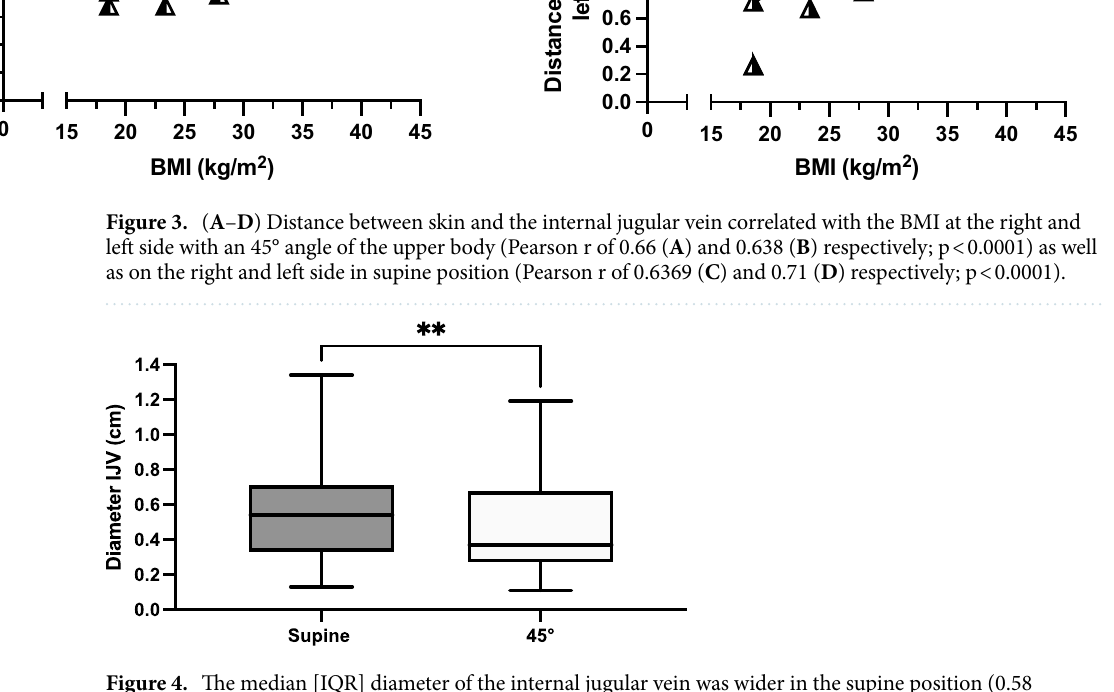
Figure 4. The median [IQR] diameter of the internal jugular vein was wider in the supine position (0.58 [0.37–0.72] mm) as compared to the 45° upright position (0.35 [0.26–0.63] mm) (**p = 0.0076, paired